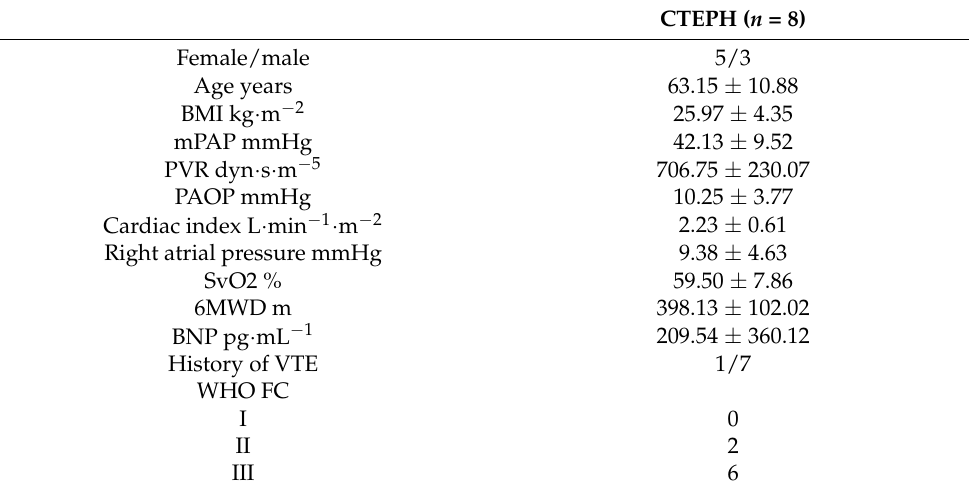
Table 1. Clinical features and hemodynamic